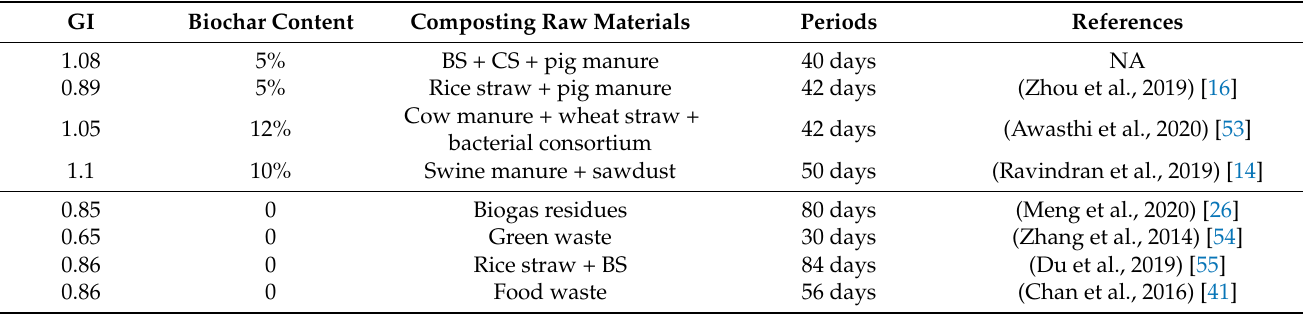
Table 5. Comparison of GI of composting with and without biochar by different